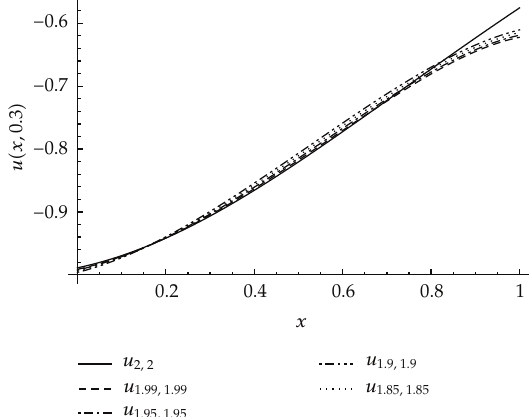
Figure 6: u (cid:2) x, 0 . 3 (cid:3) of Example 4.2 Case 3 for 4th-order HPM approximation as parameterized by α and β